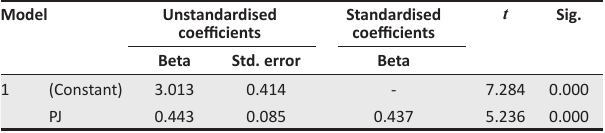
TABLE 3: Regression analysis (dependent variable: person–organisation fit; predictor: procedural